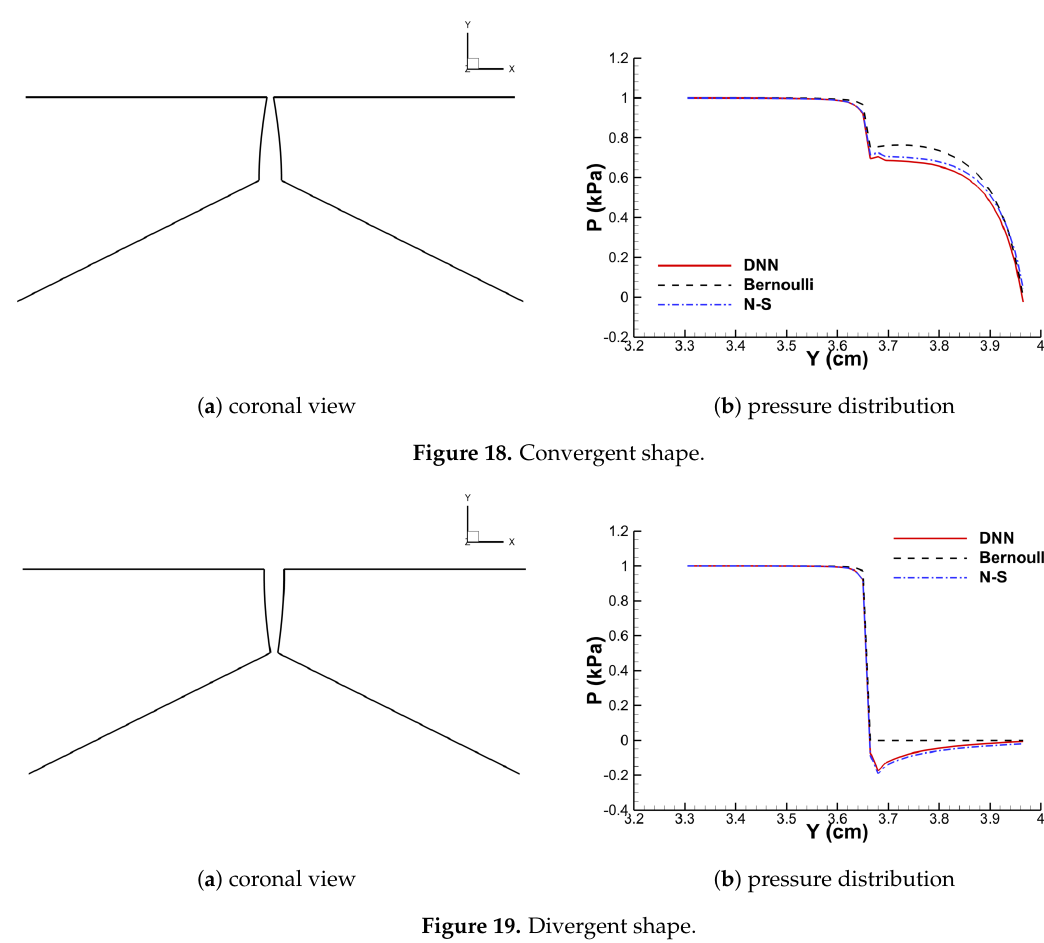
Figure 19. Divergent